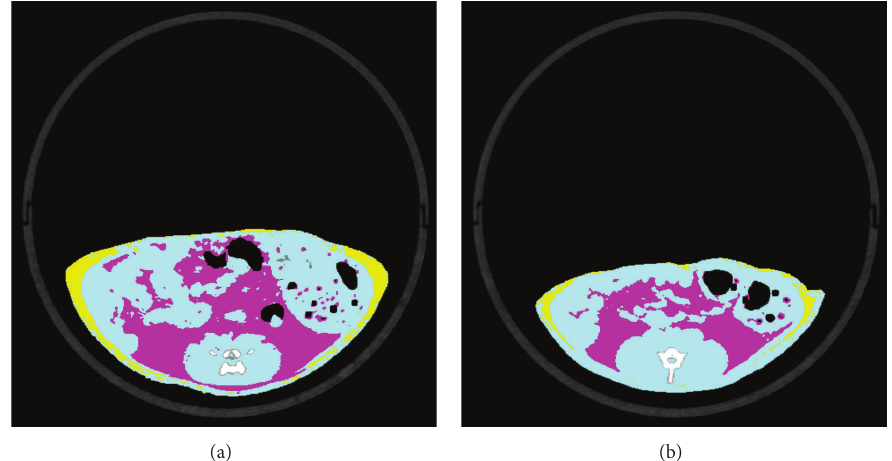
F 1: Computed tomography analysis at 12 weeks of age (representative tomogram). (a) SDT fatty rat; (b) SDT rat. Yellow: subcutaneous fat; red: visceral fat; blue: lean [14].